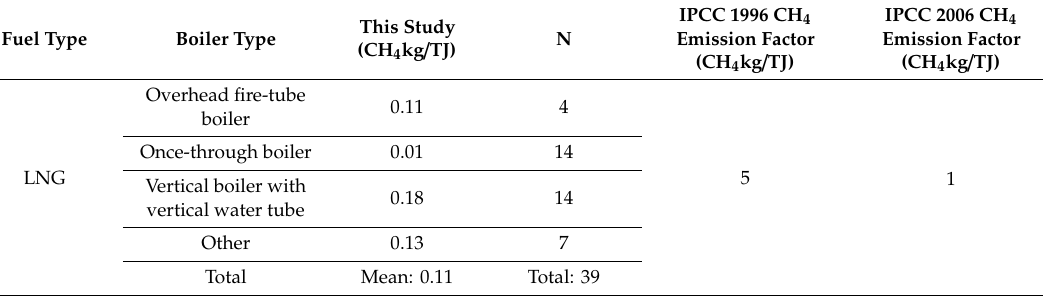
Table 4. CH 4 emission factor of LNG boiler type.